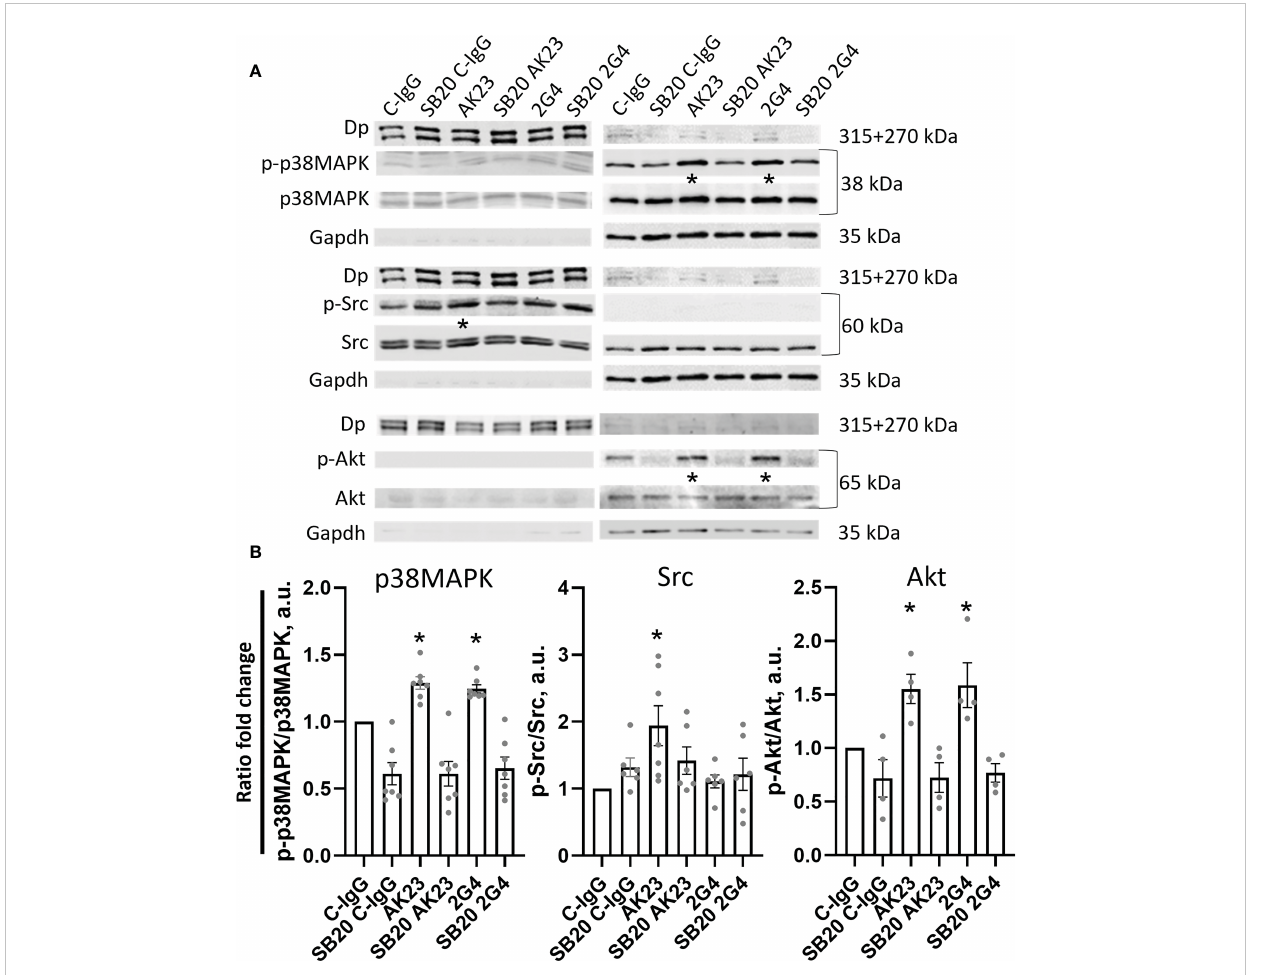
FIGURE 4 Western blot analysis reveals anti-Dsg3 epitope-speci fi c kinase phosphorylation. (A) Representative Western blot images, with respective controls for Triton-soluble (membranous+cytosolic fraction, right) Gapdh and Triton-insoluble (cytoskeleton/desmosome-bound fraction, left) Dp. The cells were treated with either C-IgG, AK23 or 2G4 with or without pre-treatment with SB20 for 1 h, to inhibit p38 MAPK. (B) Quanti fi cation of differences in phosphorylation of the investigated proteins from the WB results. Signi fi cant changes were observed and quanti fi ed in the soluble fraction for p38MAPK and Akt and the insoluble fraction for Src (N=4-7). * marks statistically signi fi cant differences between the two conditions indicated in two- way-ANOVA with Sidaks correction for multiple comparisons,